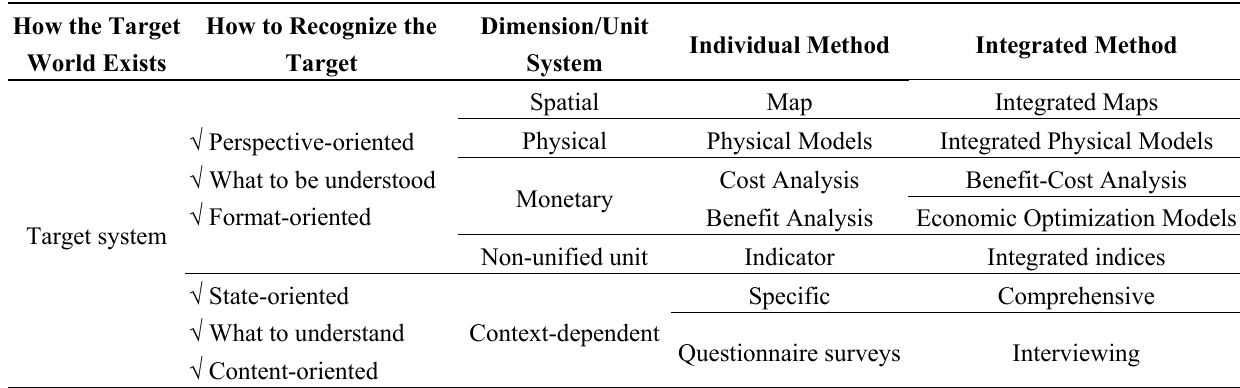
Table 3. We re-categorized each method from the ontology engineering perspective.